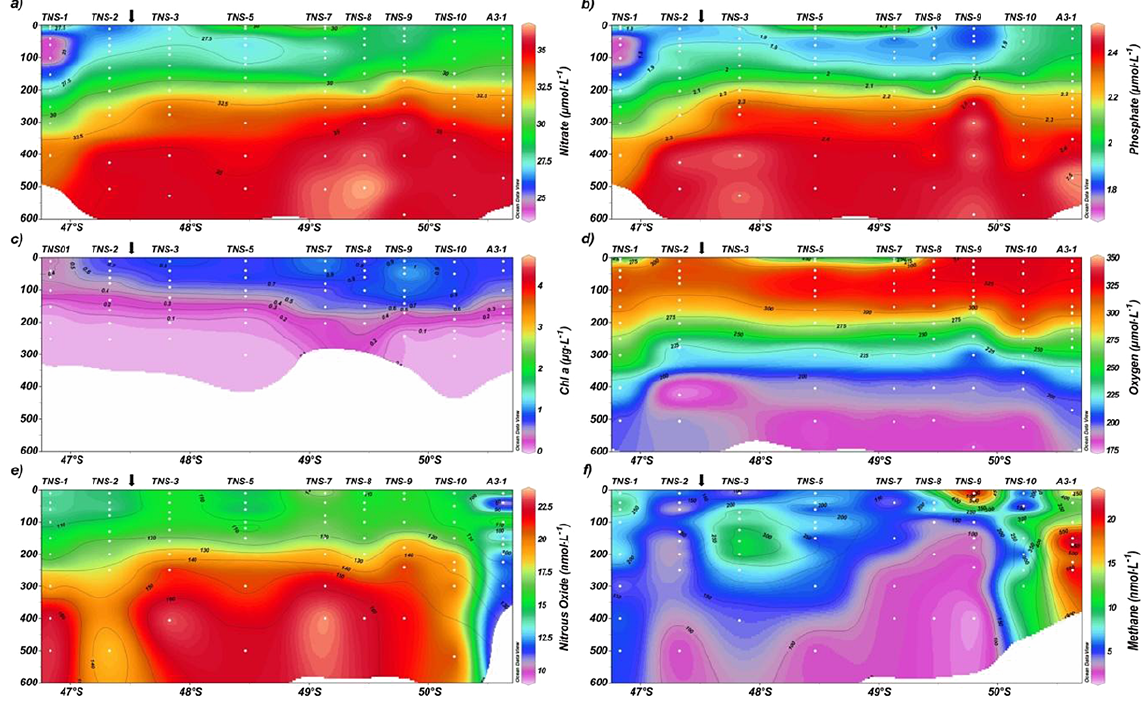
Figure 4. Vertical cross section of (a) nitrate (µmolL − 1 ) , (b) phosphate (µmolL − 1 ) , (c) chlorophyll a (µgL − 1 ) , (d) dissolved oxygen (µmolL − 1 ) , (e) nitrous oxide (nmolL − 1 ) , (f) methane (nmolL − 1 ) for the meridional transect between 45 ◦ and 51 ◦